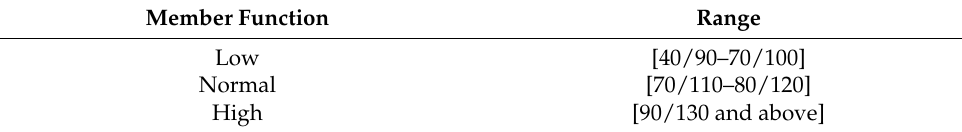
Table 3. Blood pressure—member function and its range.